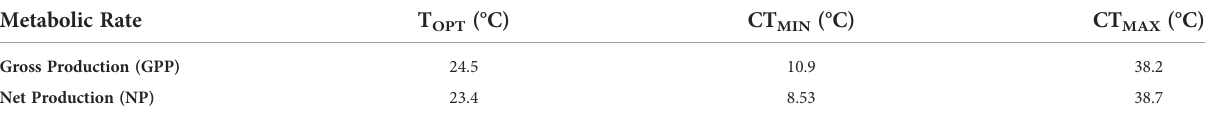
TABLE 2 Parameters associated with thermal performance curve for gross primary production (GPP) and net production (NP). Metabolic Rate Gross Production